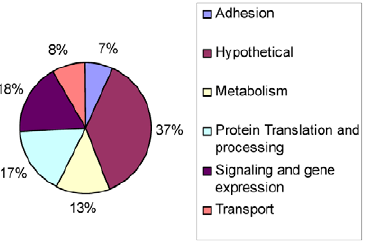
Figure 4. Types of genes modulated by TgGCN5-A during alkaline stress. Pie chart displays GO categories of genes that were not up-regulated in D GCN5-A parasites relative to wild-type (p , 0.001) after culture in alkaline (pH 8.2)